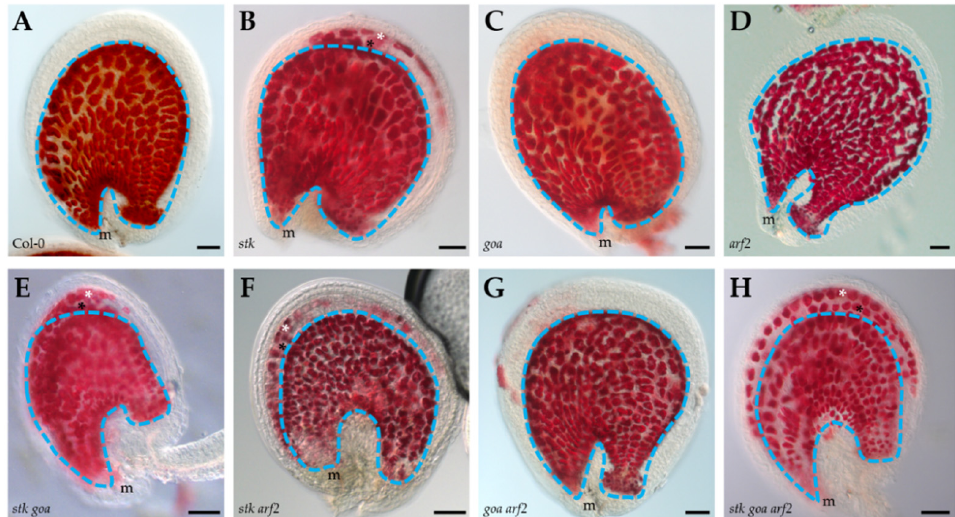
Figure 3. PAs accumulation in wild type and mutant seeds. Pink staining indicates PAs accumulation. Accumulation of PAs in the endothelium is marked by blue outline, while ectopic accumulation is marked by black asterisks (second layer) and white asterisks (third layer). For each one of the analyzed genotypes, n > 25 seeds were examined and representative image of the phenotype is presented; WT ( A , n = 58), stk ( B , n = 62), goa ( C , n = 76), arf2 ( D , n = 26), stk goa ( E , n = 33), stk arf2 ( F , n = 43), goa arf2 ( G , n = 38), stk goa arf2 ( H , n = 25). Scale bar = 50 μ m. m, mycropile.